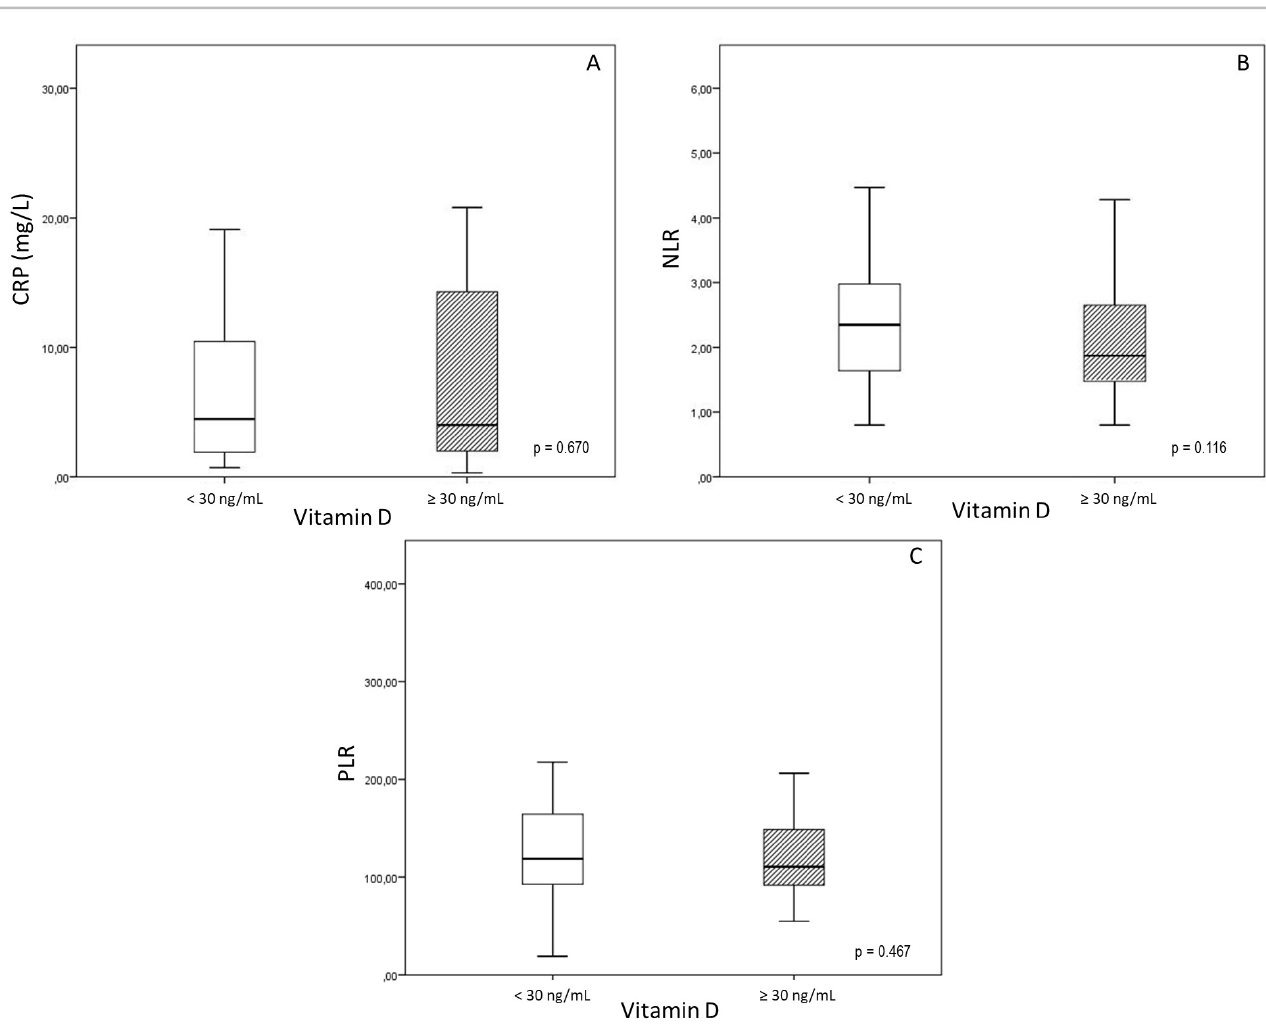
FIGURE 1 - Inflammatory markers according to the presence and absence of hypovitaminosis D of the elderly assessed in the study. CRP, C-reactive protein; NLR, neutrophil to lymphocyte ratio; PLR, platelet to lymphocyte